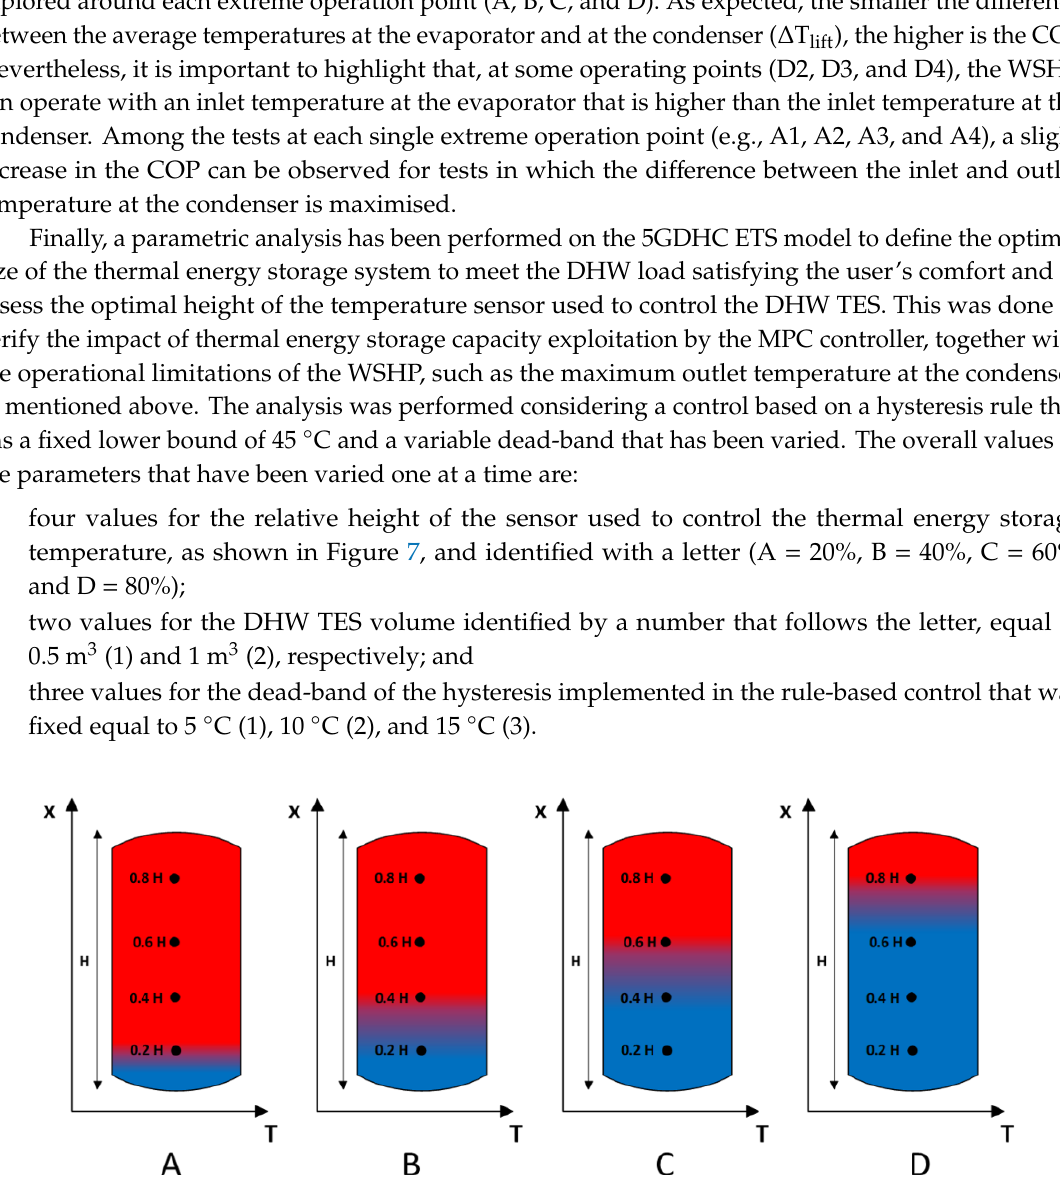
Figure 7. Schematisation of the thermal energy storage state-of-charge at the end of the charging process for the different positions of the sensor used to control the thermal energy storage temperature identified with the relative height of the sensor with respect to the total height of the tank (A = 20%, B = 40%, C = 60%, and D = 80%).